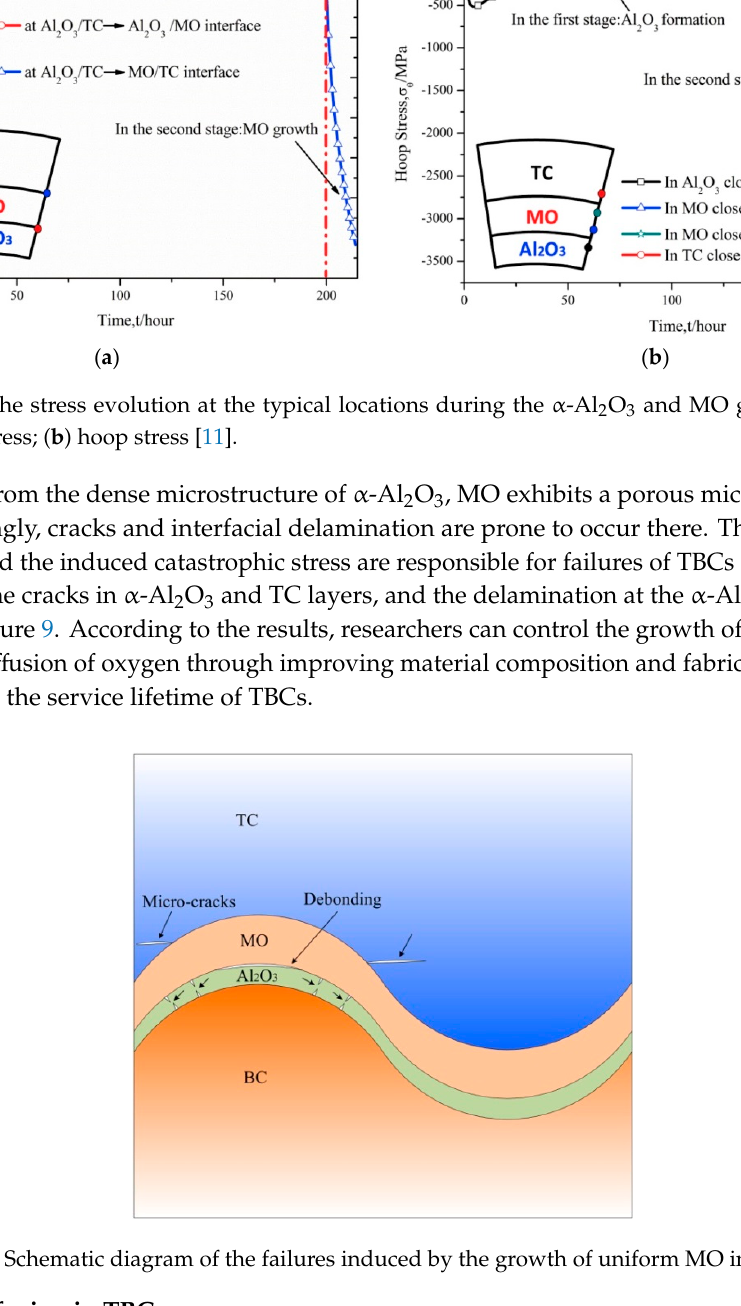
Figure 8. The stress evolution at the typical locations during the α -Al 2 O 3 and MO growth stages; ( a ) radial stress; ( b ) hoop stress [11].